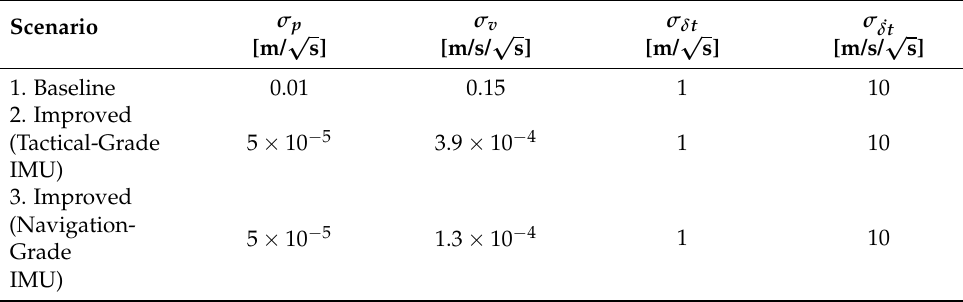
Table 12. Process noise definition per scenario type.